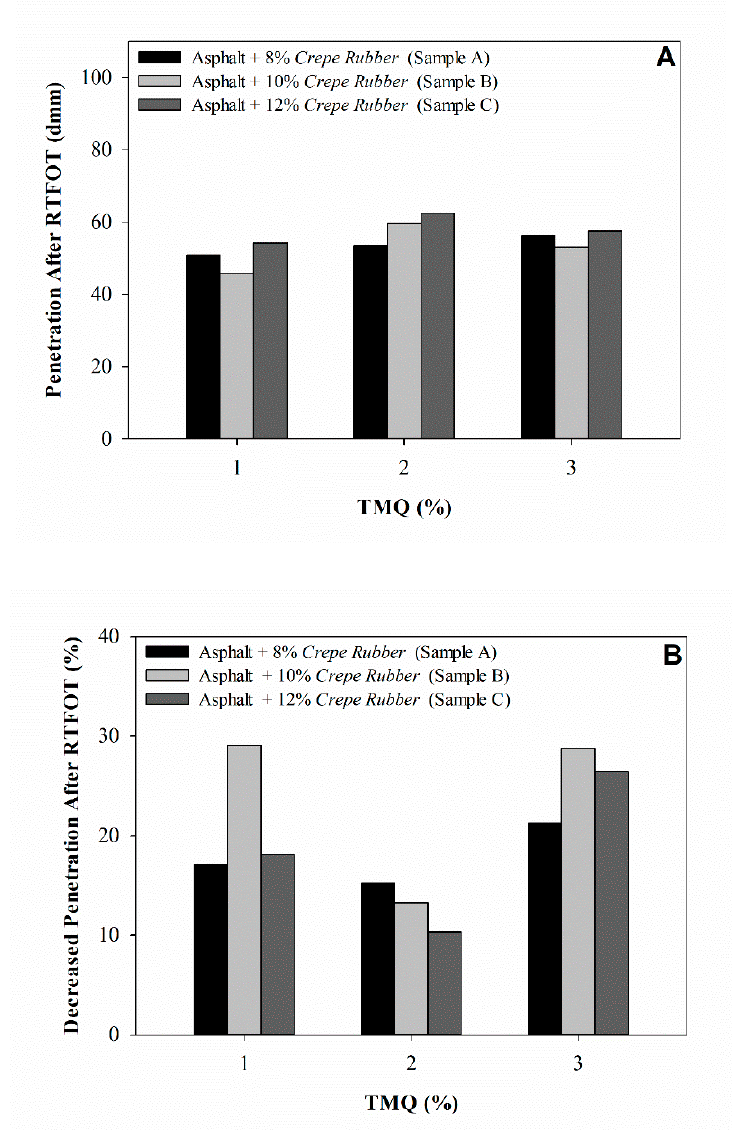
Figure 4. ( A ) Penetration after RTFOT. ( B ) Percentage of decreased penetration after RTFOT.